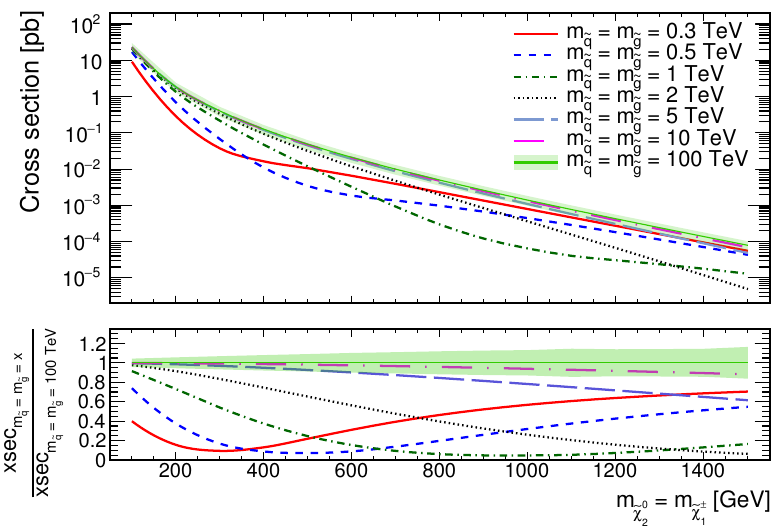
p (cid:31) (cid:6) (cid:31) 0 production at s = 13 TeV versus the wino mass, calculated to 2 1 (cid:31) (cid:6) and (cid:31) 0 are assumed to be mass-degenerate 2 1 e e e e